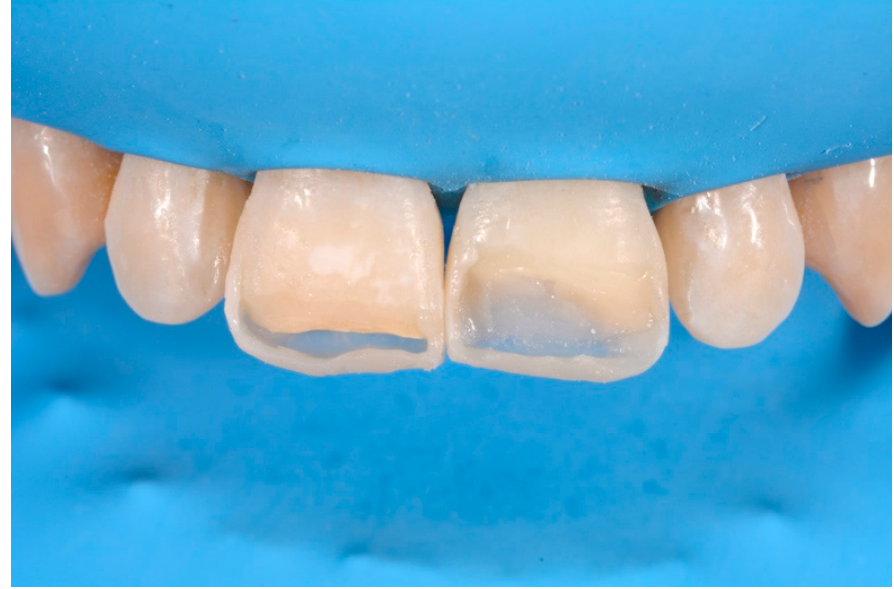
Figure 59. Completing the restorations without previously reducing the incisal frame could provide an unpleasant final esthetic